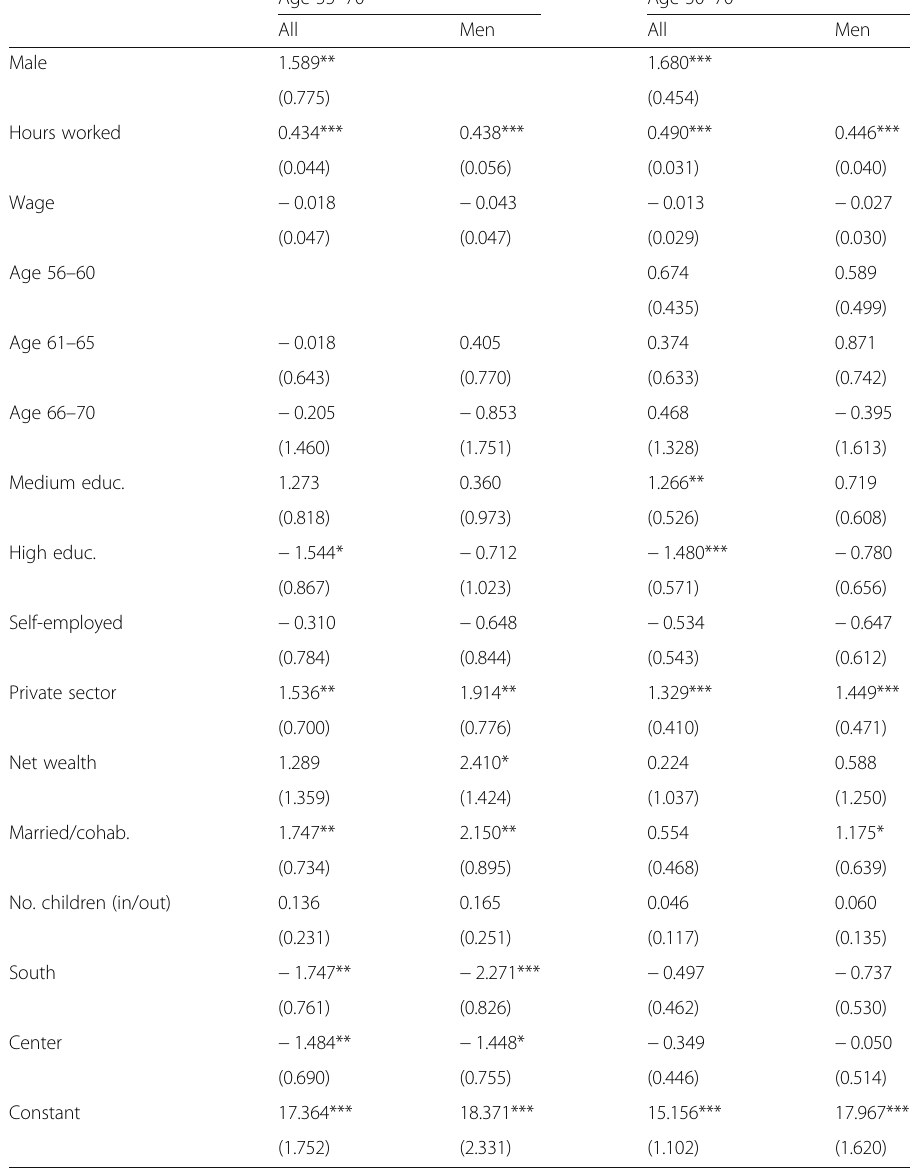
Table 6 Desired working hours,